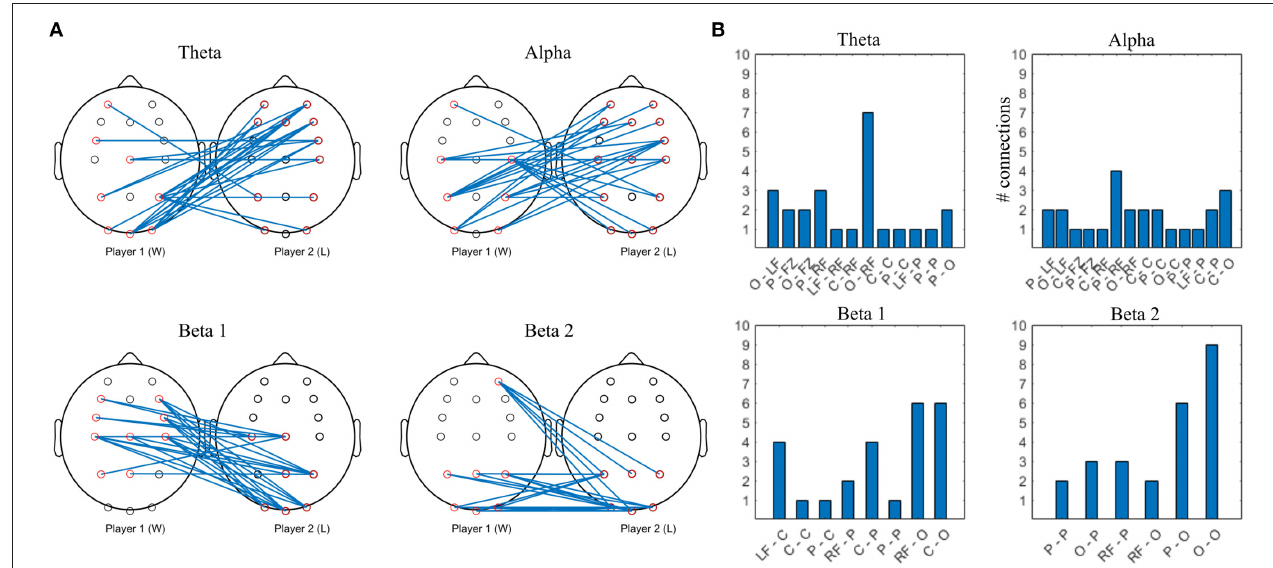
FIGURE 12 | Top 10% strongest connections in competitive gaming, interbrain connectivity. (A) topographical plot. (B) grouped locations. W, first letter; L, second letter. LF, left frontal; RF, right frontal; C, central; P, parietal; O,